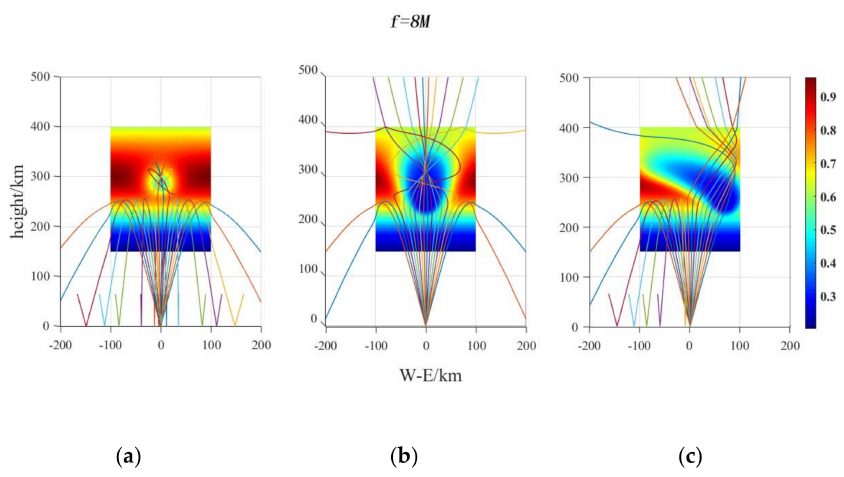
Figure 4. 3D ray-tracing simulation of 8 MHz short wave propagation path after 100 s of H 2 released by rocket under different flight paths (electron density unit: 10 6 cm − 3 ): ( a ) 300 km fixed − point